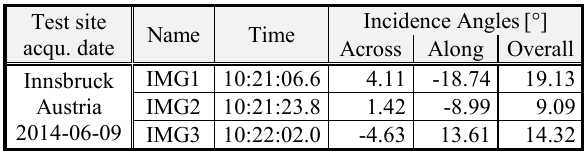
Table 2. Acquisition parameters of the Pléiades